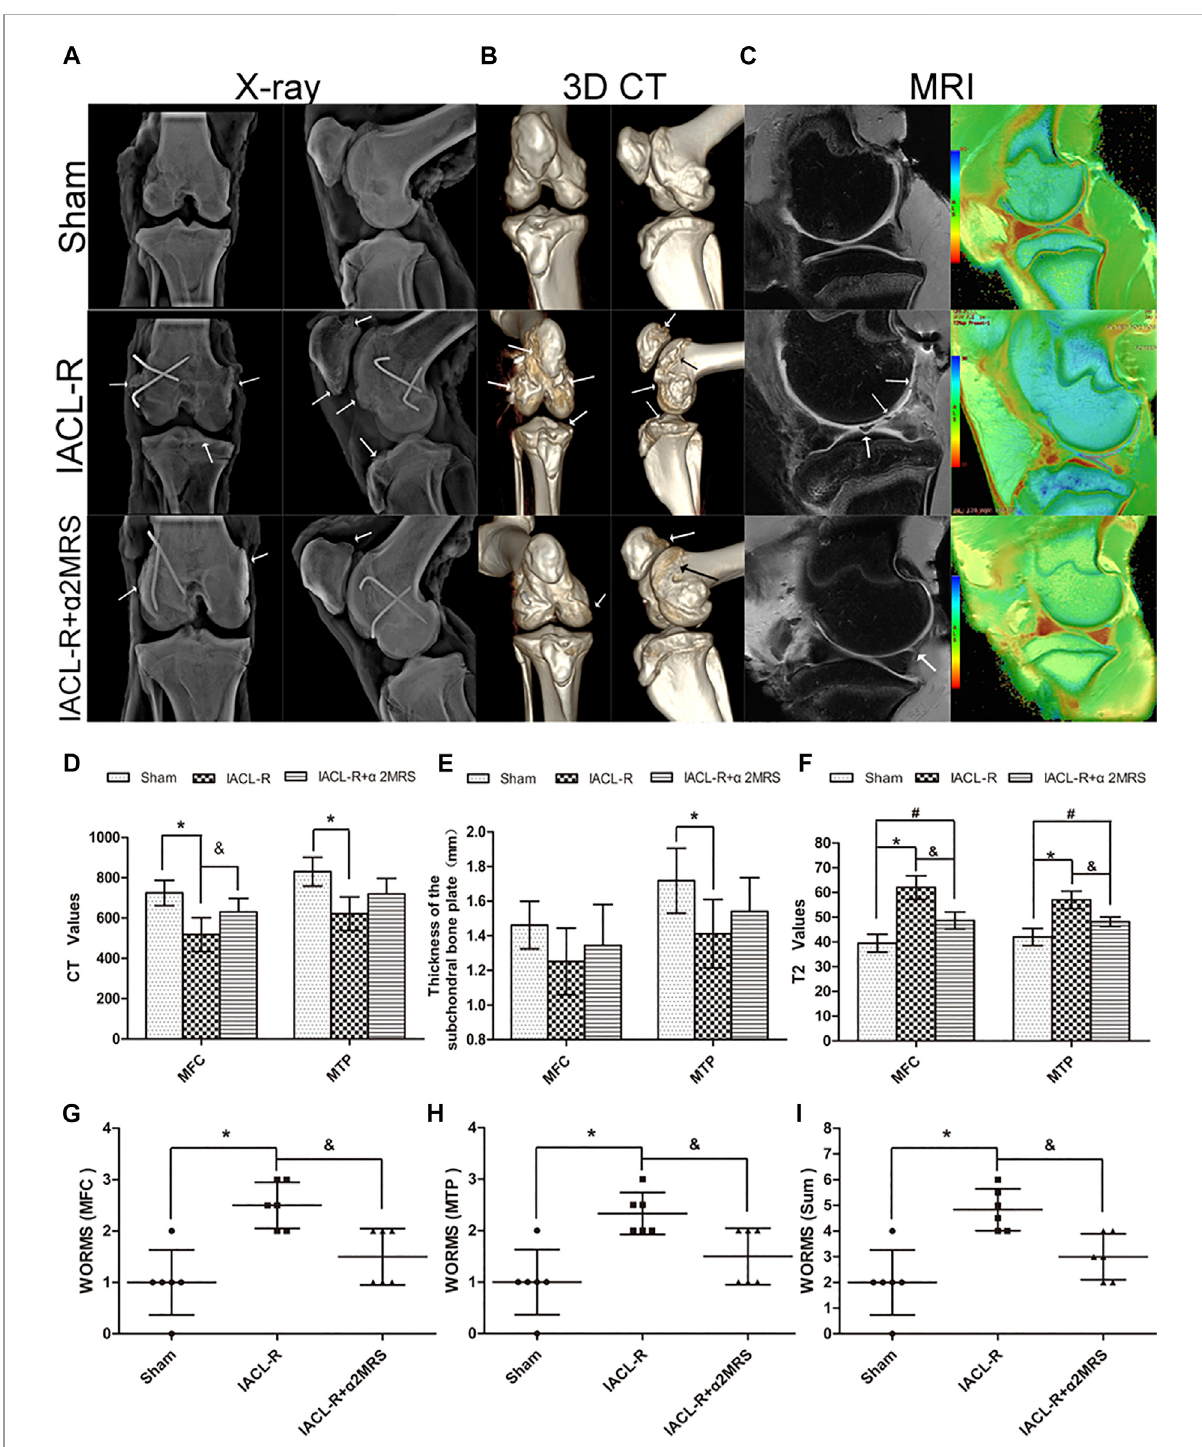
FIGURE 6 Imaging assessments (A) : X-ray examination;( B) : three-dimensional CT reconstruction;( C) : MRI examination (left: Osag fs PD; right: Osag T2MAP). (D) :The CT valuesof thesubchondral bone plate. sham group (medial femoralcondyle,724.2 ± 62.95; medial tibial plateau, 830.3 ± 71.26); IACL-R group (medial femoral condyle, 517.7 ± 83.89; medial tibial plateau, 621.2 ± 83.57); IACL-R+ α 2MRS group (medial femoral condyle, 630 ± 66.9; medial tibial plateau, 719.2 ± 76.73). (E) : The thickness of the subchondral bone plate. sham group (medial femoral condyle, 1.46 ± 0.14; medial tibial plateau, 1.72 ± 0.19); IACL-R group (medial femoral condyle, 1.25 ± 0.19; medial tibial plateau, 1.41 ± 0.20); IACL-R+ α 2MRS group (medial femoral condyle, 1.35 ± 0.24; medial tibial plateau, 1.54 ± 0.19). (F) : Quanti fi cation of the T2 values obtained using MRI sag